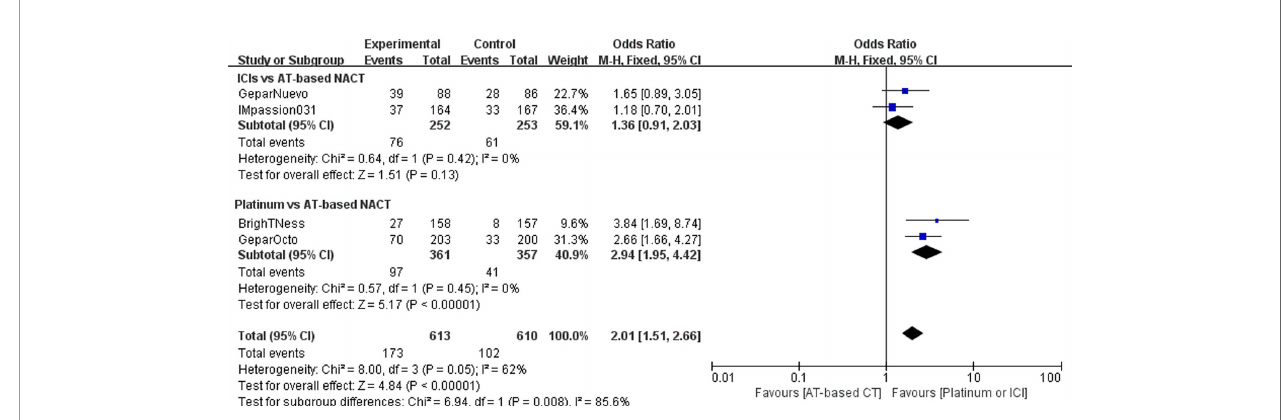
FIGURE 8 | Forest plot showing pooled incidence of discontinuation due to AE in patients receiving ICIs vs AT-based NACT and platinum-based vs AT-based NACT in early